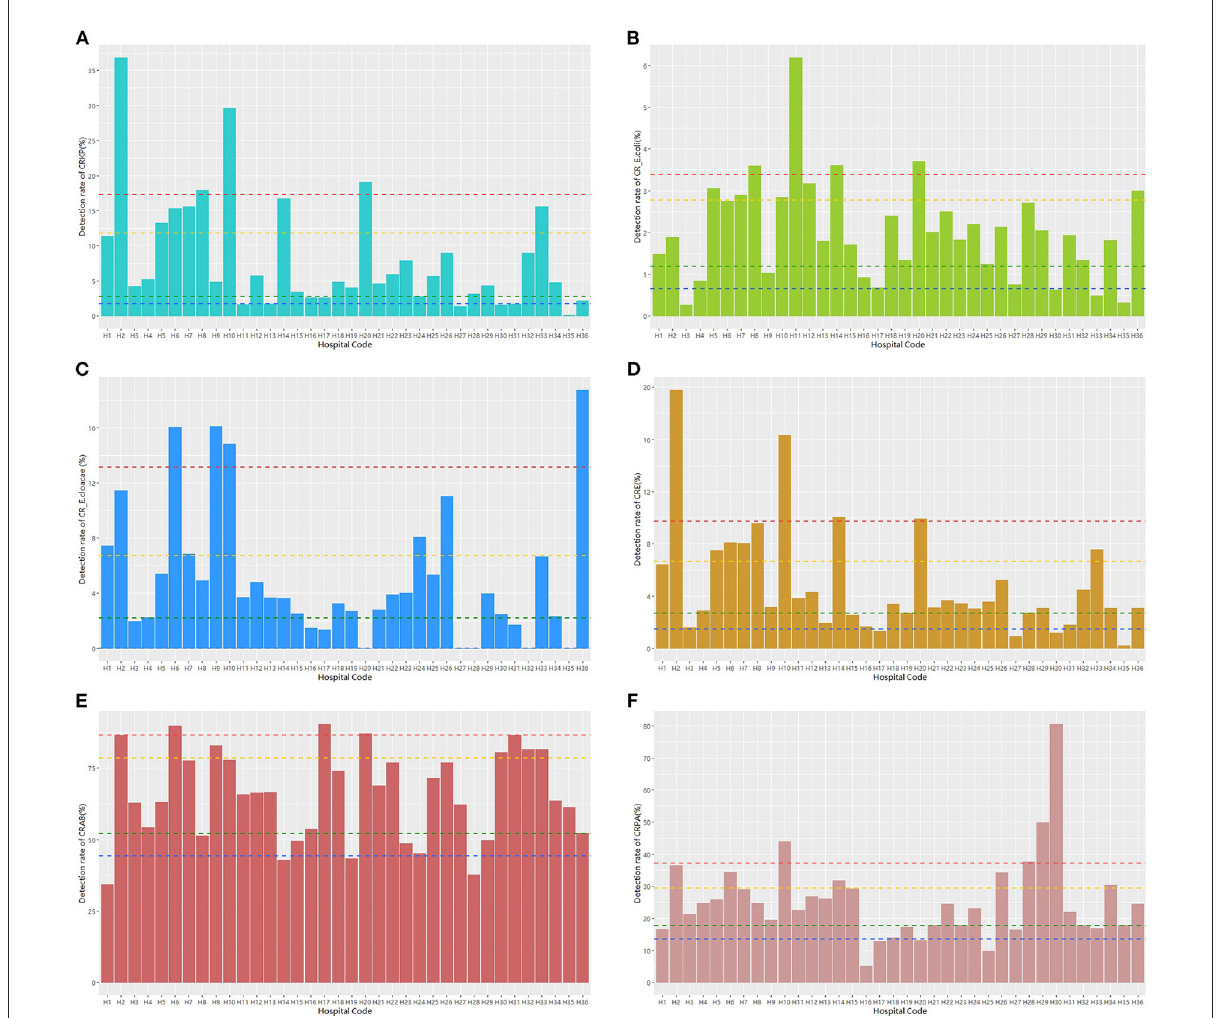
FIGURE2 The detection rate distribution of different carbapenem-resistant bacteria. Notes: blue dashed line: the 10th percentile; green dashed line: the 25th percentile; yellow dashed line: the 75th percentile; and red dashed line: the 90th